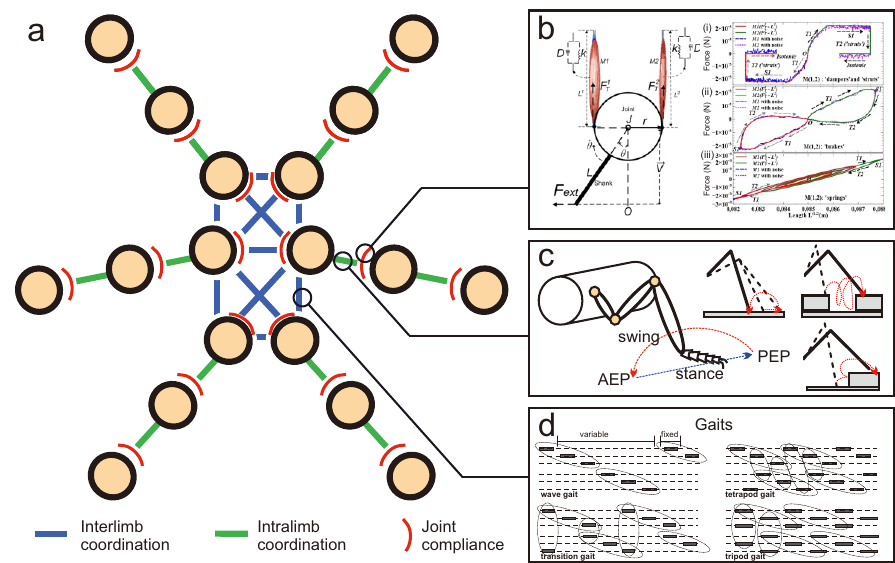
Joint complianceIntralimb coordinationInterlimb coordination Figure 5. ( a ) Overview of locomotion control involving interlimb coordination (coordination be- tween legs), intralimb coordination (coordination between joints in a leg), and joint compliance (a property of joint with variable stiffness). ( b ) Example of joint compliance generated by an adaptive bio-inspired muscle model (modified from [115]). Using this model, a leg joint can behave like dampers, struts, brakes, or springs (modified from [115]). ( c ) Example of intralimb coordination in the swing and stance phases of the leg and different reflexes for walking on uneven terrain (modified from [116–118]). ( d ) Example of interlimb coordination which results in different gaits (modified from [119]). The main observed gaits from slow to fast [120] include: wave gait (only one leg lifts at any given time (swing) while the remaining legs stay on the ground (stance), and the wave travels from back to front), transition gait (front and back legs of the opposite side lift together at a given time while the other legs stay on the ground), tetrapod gait (diagonal pairs of legs lift together at a given time while at least four legs stay on the ground), and tripod gait (front and back legs of one side and the middle leg of the opposite side lift together at a given time while the remaining three legs stay on the ground). While the articles specify specific gaits, it is important to note that certain insects (such as stick insects [121,122], cockroaches [123], and flies [124]) frequently change their gaits depending on their locomotion speeds and situations